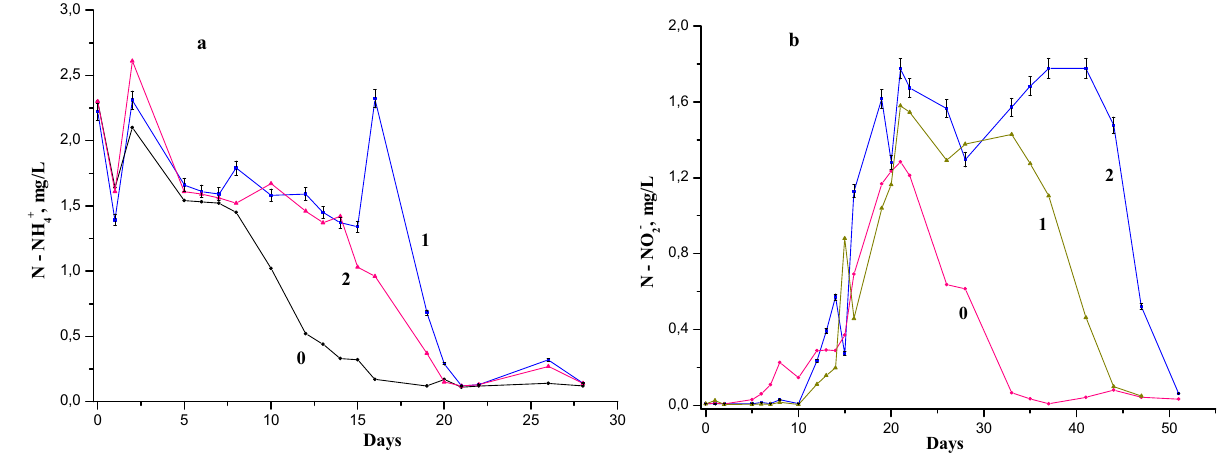
Figure 6. The dynamics of ( a ) ammonium (0—reference sample, 1—with 0.5 mg/L, 2—with 0.05 mg/L of diphenylamine) and ( b ) nitrite ions (0—reference sample, 1—with 0.05 mg/L, 2—with 0.5 mg/L, of diphenylamine) in model samples with 3 mg/L NH 4 + in the Nistru River